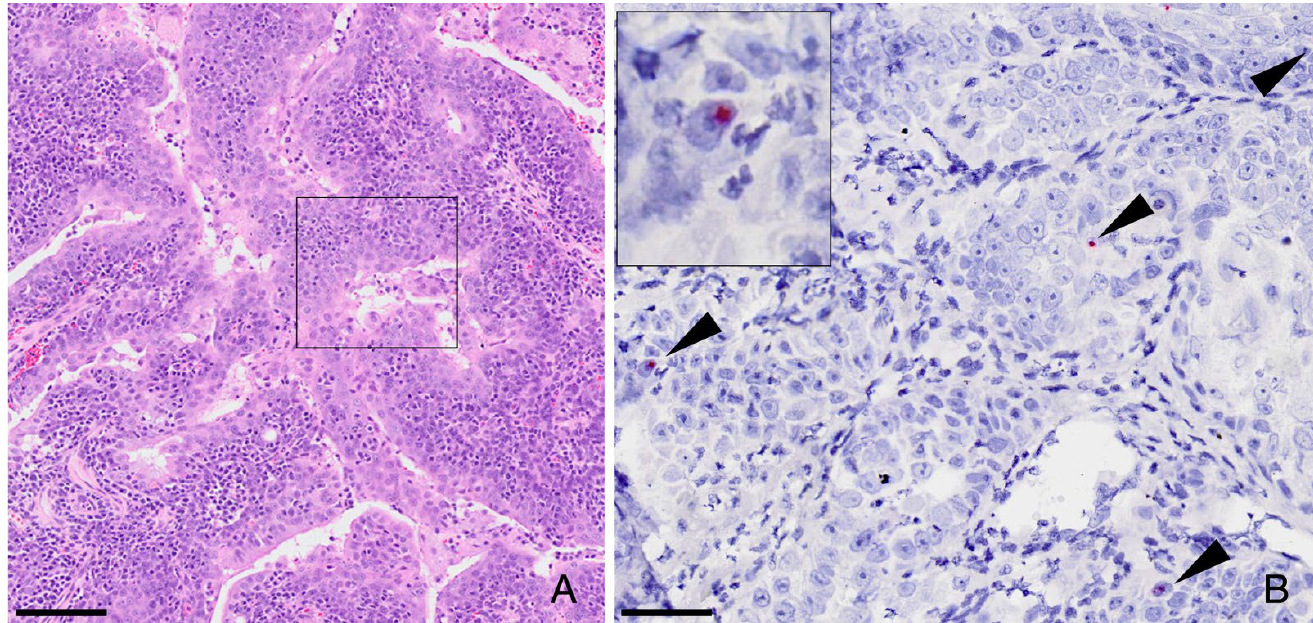
Figure 2. In situ hybridization, papillary carcinoma in a domestic cat. ( A ) Fronds of neoplastic epithelium characteristic of a papillary carcinoma, hematoxylin and eosin. Bar 100 µ m ( B ) Among eleven tumors tested in this single case, there was rare probe hybridization in scattered nuclei of neoplastic cells (arrowheads and inset). Bar 50µm